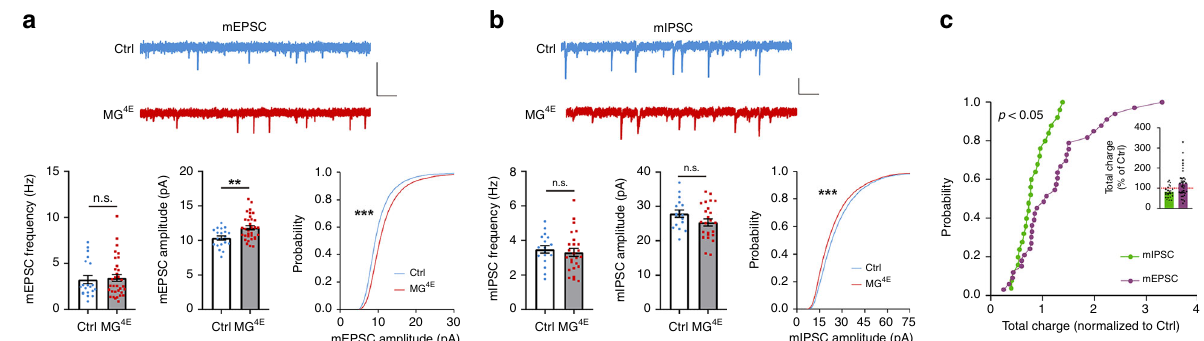
Fig. 6 Abnormal synaptic function in male MG 4E mice. a mEPSCs recorded in mPFC layer 5 neurons of male control and MG 4E mice at 6 – 7 weeks of age. n = 20 cells from fi ve control mice and 33 cells from 8 MG 4E mice. Two-sided t -test for frequency and amplitude: ** p = 0.0022; n.s. not signi fi cant. Two- sided Kolmogorov – Smirnov test for cumulative probability of mEPSC amplitude: *** p < 0.001. Scale bars, 50 pA (vertical) and 0.5 s (horizontal). b mIPSCs recorded in mPFC layer 5 neurons of male control and MG 4E mice at 6 – 7 weeks of age. n = 17 cells from 4 control mice and 25 cells from 6 MG 4E mice. Two-sided t -test for frequency ( p = 0.6053) and amplitude ( p = 0.1097): n.s. not signi fi cant. Two-sided Kolmogorov – Smirnov test for cumulative probability of mIPSC amplitude: *** p < 0.001. Scale bars, 25 pA (vertical) and 0.5 s (horizontal). c Relative changes in mEPSC ( n = 33 cells) and mIPSC ( n = 25 cells) total charge transfer in MG 4E mice, normalized to control mice. p = 0.0453 by two-sided Kolmogorov – Smirnov test. All data are shown as mean ± s.e.m. Source data are provided as a Source Data